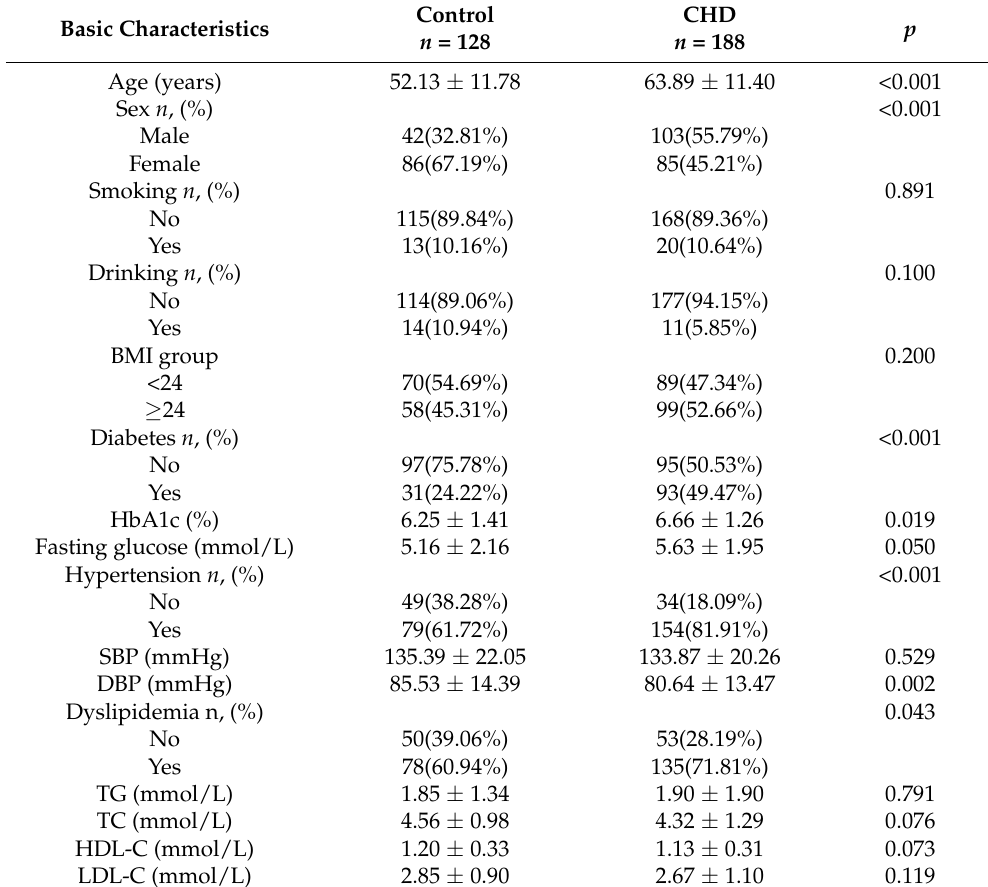
Table 1. Patient characteristics between coronary heart disease (CHD) and cardiometabolic disorders. Basic